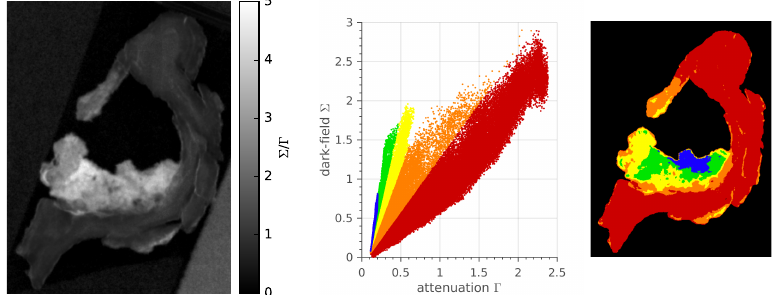
Figure 7. Normalised scatter image of the iron fibula, acquired at 80kVp and 22.5mAs per phase-step ( left ). The scatter plot and image ( right ) show the abundance of measured Γ - and Σ -values for the iron fibula with the colours referring to different regions in the Γ - Σ -plain, respectively in the fibula image on the